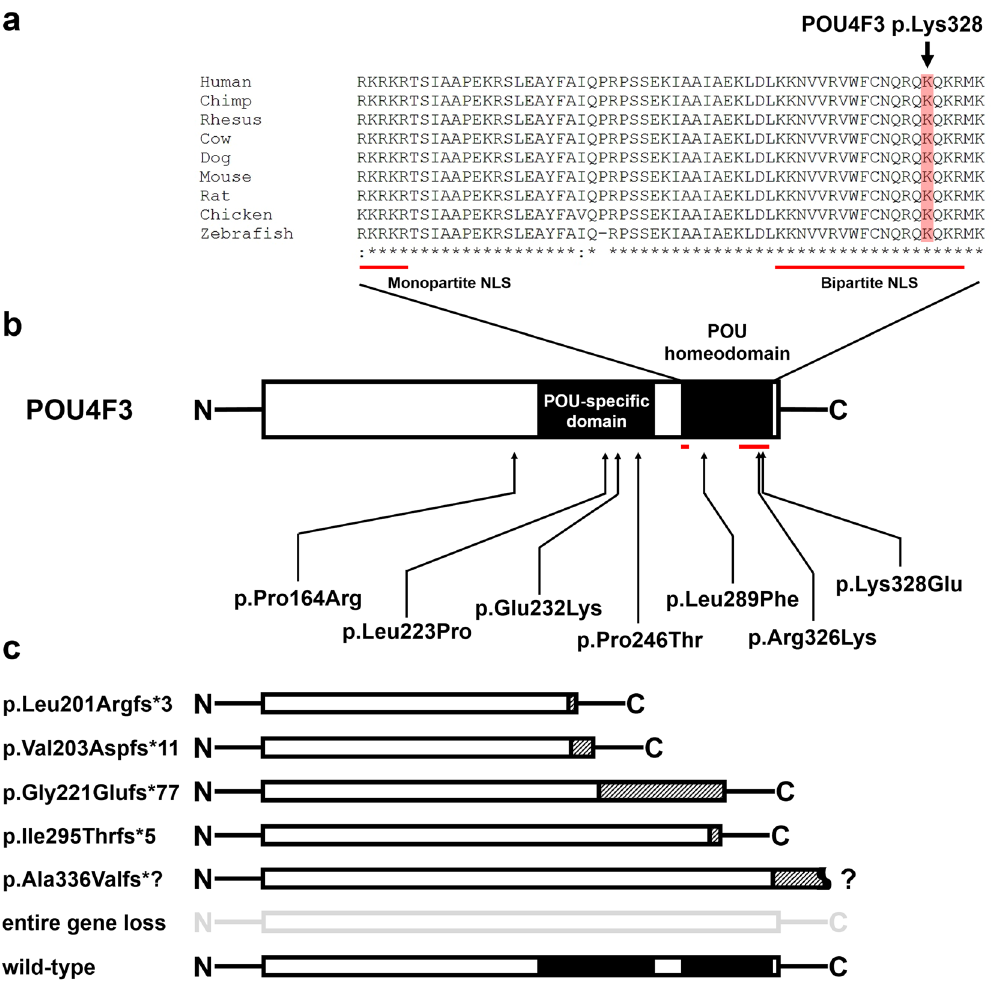
Figure 2. ( a ) The POU4F3 p.Lys328 indicated in red shading was located within the bipartite nuclear localization signal (NLS) in the POU homeodomain. The bipartite NLS was conserved across nine species. ( b ) The location of six reported POU4F3 missense variants and p.Lsy328Glu. POU-specific domain and POU homeodomain are indicated by black boxes. Two NLSs were indicated by red lines. ( c ) The predicted protein products of five reported POU4F3 frameshift variants. Boxes with slash indicate the new amino acid sequences after the